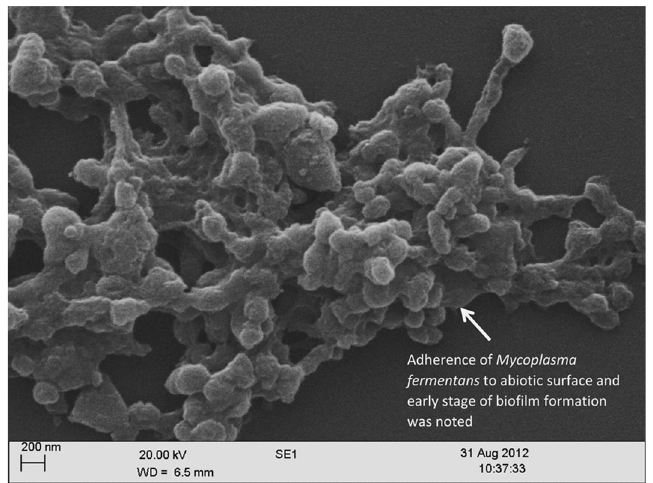
Figure 1. Representative scanning electron microscopy image of Mycoplasma fermentans ATCC19989 biofilm on glass coverslip illustrating an initial biofilm formation (arrow). This process was observed in all strains under examination.